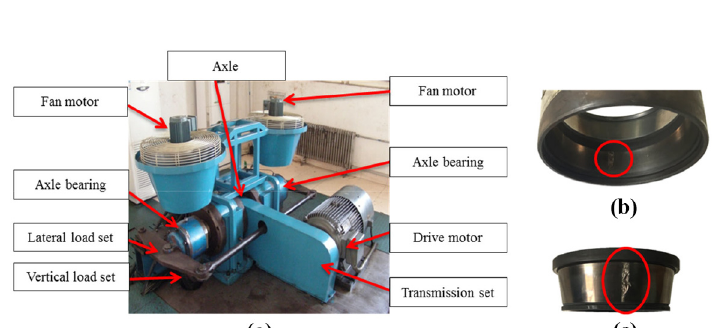
Figure 4. Extracted fault signal and its frequency spectrum